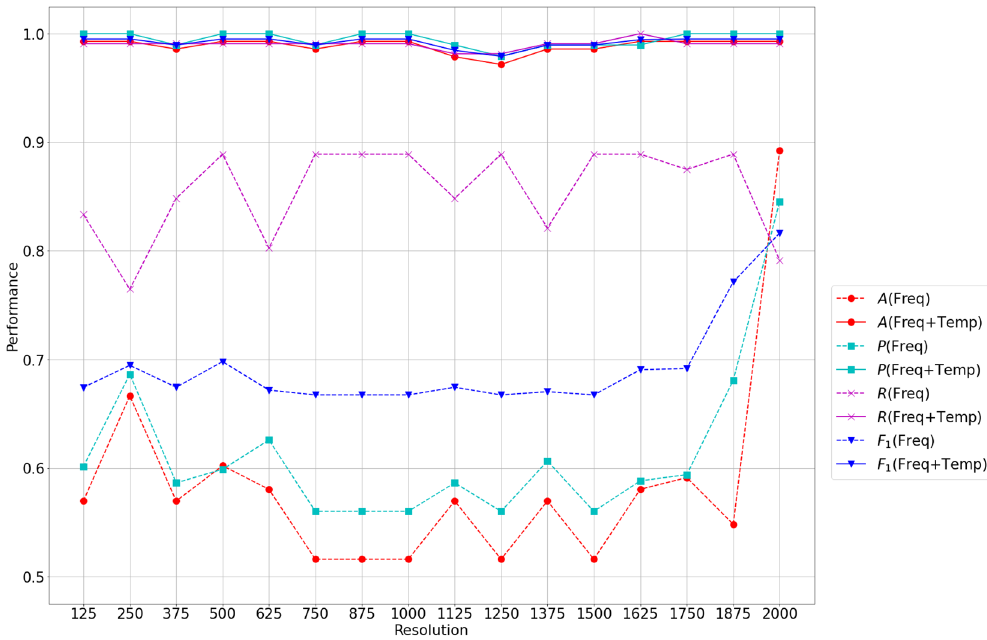
Figure 5. Performance evaluation of the proposed model in terms of accuracy (A), precision (P), recall (R), and F 1 measure ( F 1 ) as a function of frequency resolution. Solid and dotted lines indicate the results of training the signal in the frequency spectrum (Freq) and spectrogram (Freq+Temp),